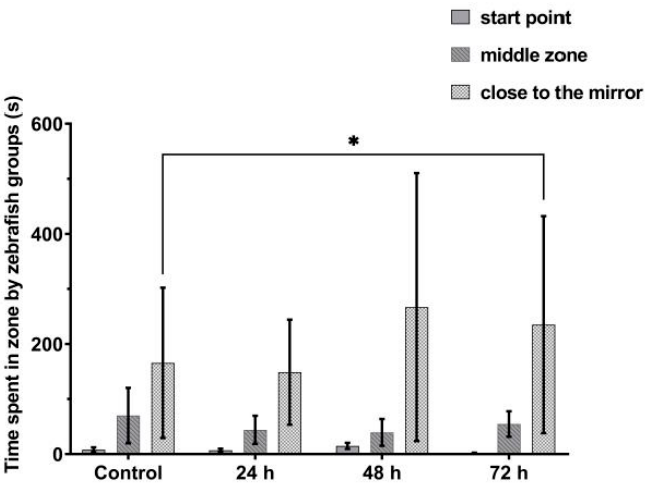
Figure 9. The amount of time spent by zebrafish groups during the aggression test. Group 1, control ( n = 30); Group 2, group exposed for 24 h to VPA ( n = 24); Group 3, group exposed for 48 h to VPA ( n = 24); and Group 4, group exposed for 72 h to VPA ( n = 22). The data is represented as average ± SEM. Anova and Tukey post-hoc tests, p < 0.05 was considered to be significant. The experimental groups were compared to control group, where * p < 0.05.